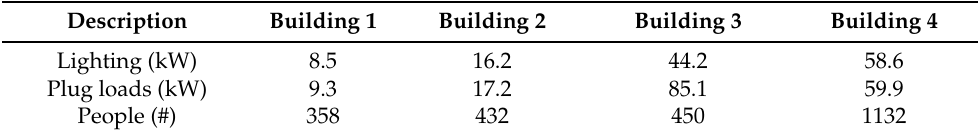
Table 4. Building internal heat gains: total installed power and people.